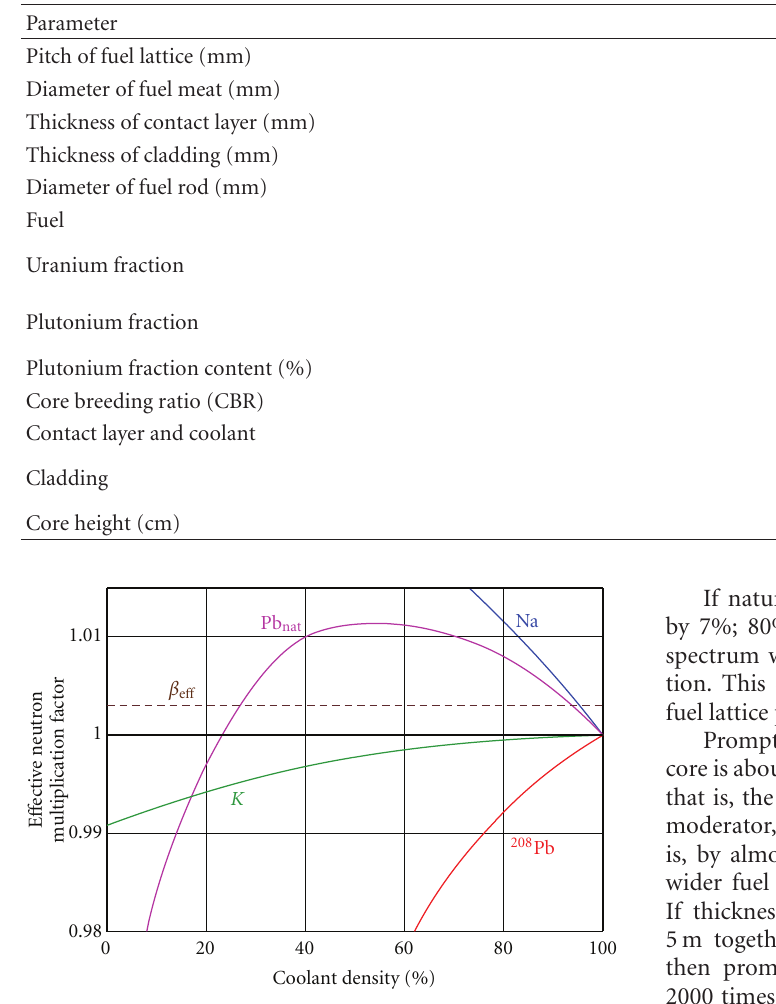
Figure 3: Comparison of coolants: dependence of K e ff on coolant density.